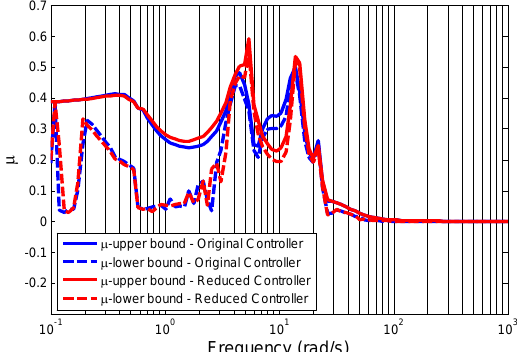
Figure 8. Robust performance analysis (upper and lower bounds) for original and reduced